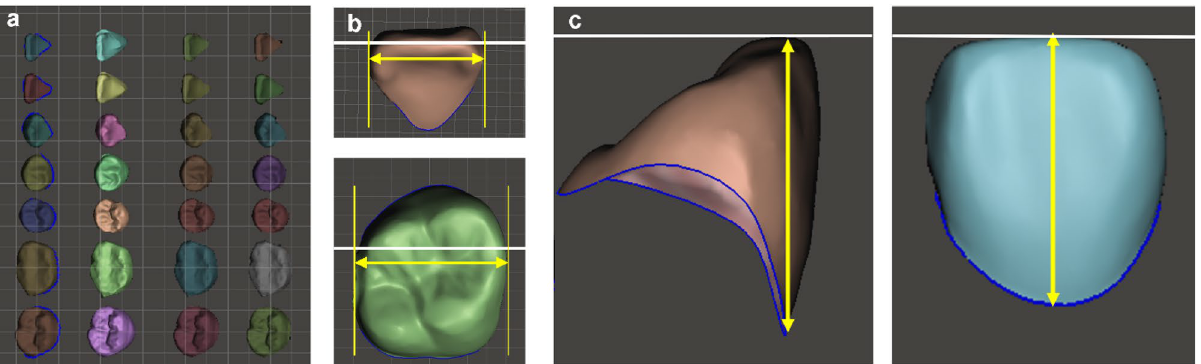
Figure 4. Measurement of the mesiodistal (MD) width and the clinical crown height (CCH) of segmented teeth. ( a ) Reorient the segmented teeth of the LS, DS, AS, and REF groups using Meshmixer software. ( b ) Measurement of the MD width of segmented teeth in REF group. ( c ) Measurement of the CCH of segmented teeth as the distance between the virtual occlusal plane and the lowest point of the gingival margin of the clinical